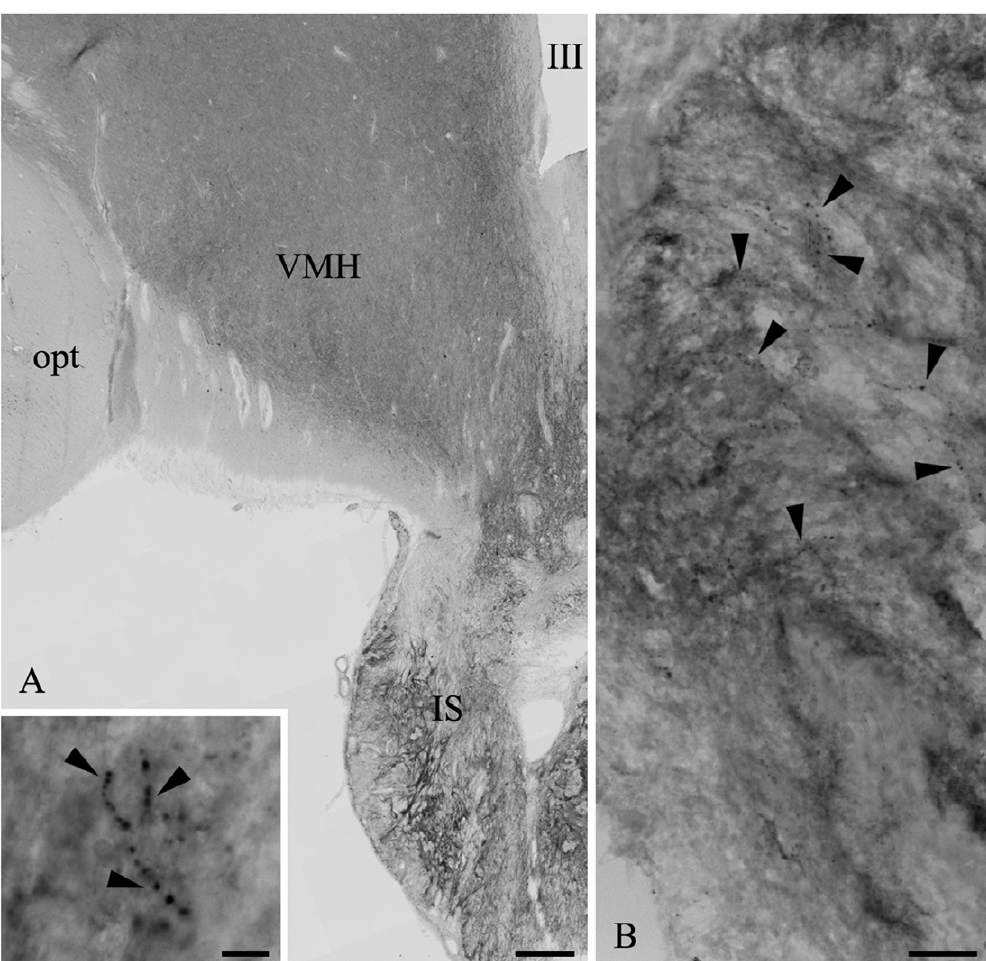
Figure 10. D3-immunoreactivity in the infundibular stalk of the human hypothalamus. ( A ) D3 immunoreactive fibers (arrowheads) are present in the human infundibular stalk (IS); these fibers are shown in medium ( B ) and high (inset in A) power micrographs. opt: tractus opticus, VMH: ventromedial hypothalamic nucleus, III: third ventricle Scale bars: 500 m m in A, 50 m m in B, 10 m m in inset.